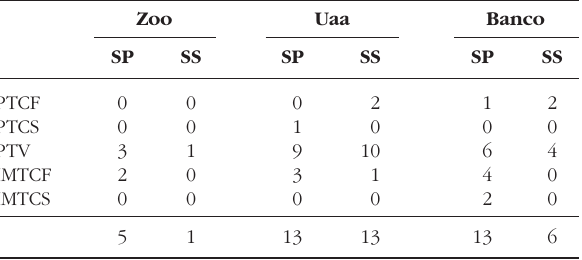
Tableau IV. – Identification par PCR des trypanosomes observés selon l’organe disséqué, en fonction du site et de la saison.